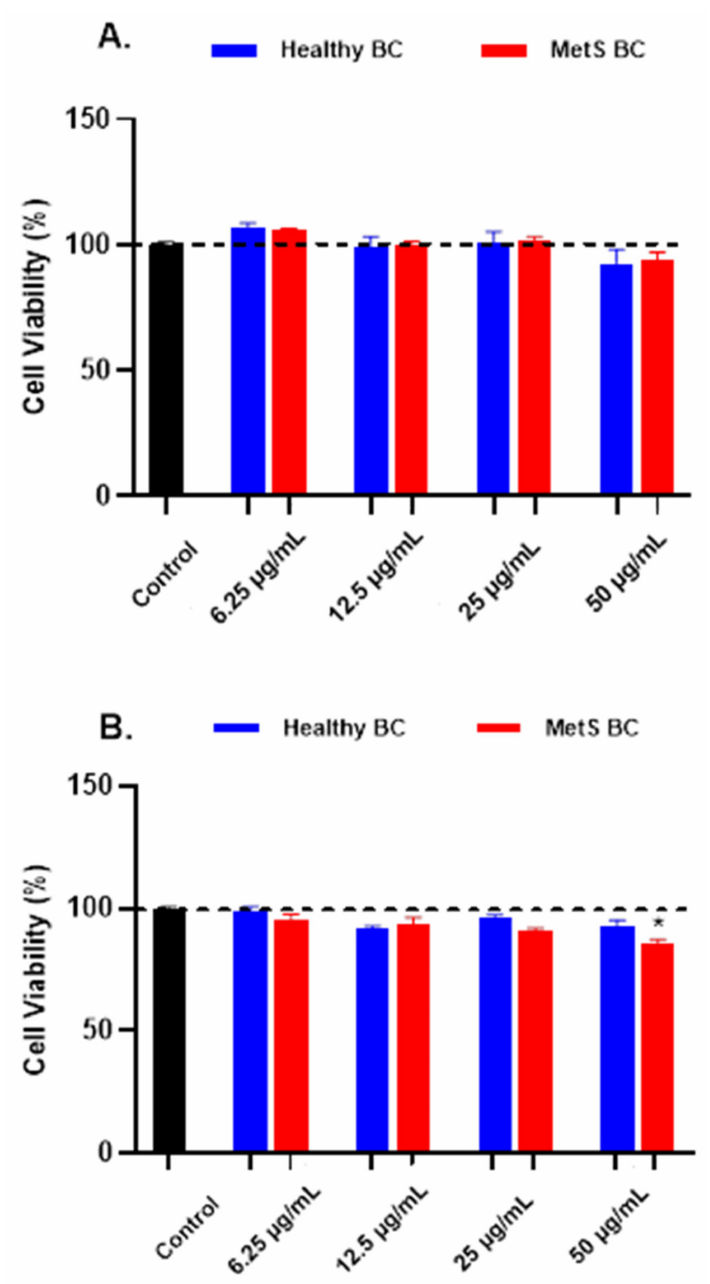
Figure 5. Cell viability following 1 h or 24 h NP with healthy or MetS BCs. Macrophages were exposed to Fe 3 O 4 NPs with BCs at concentrations of 0, 6.25, 12.5, 25, or 50 µ g/mL for 1 h ( A ) or 24 h ( B ), and cell viability was assessed through Thiazolyl Blue Tetrazolium Bromide (MTT) cell proliferation assay. Untreated cells in SFM were used as controls for the MTT assay. * Denotes statistical significance compared to the expression of control group (n = 4/group and p <